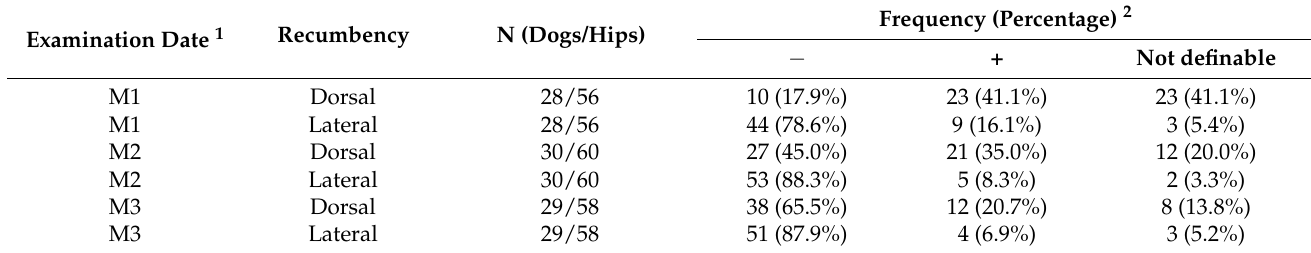
Table 2. Descriptive statistics of Barlow tests reported for each examination date.